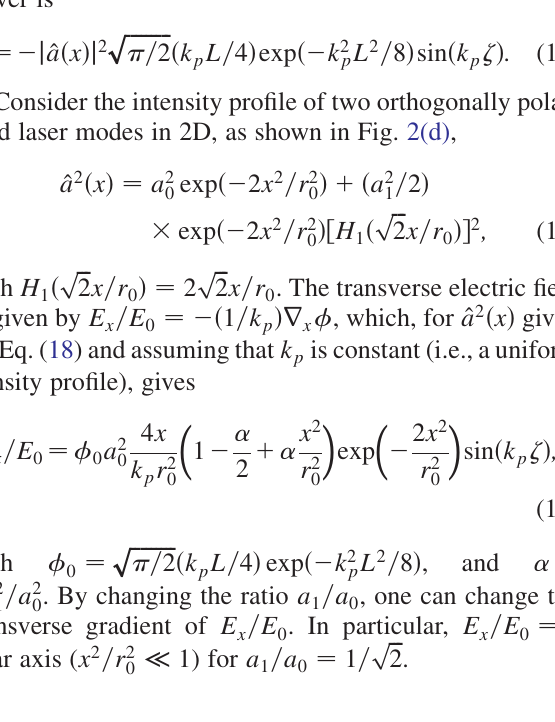
ffiffiffi p 2 ffiffiffi p 2 (bold solid line),